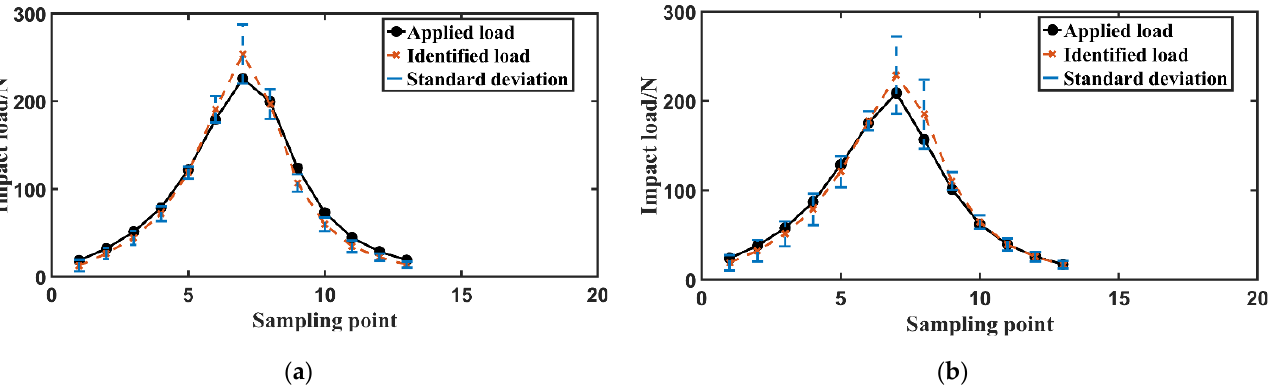
Figure 20. Impact load identification effect in original pattern of two working conditions. ( a ) Single